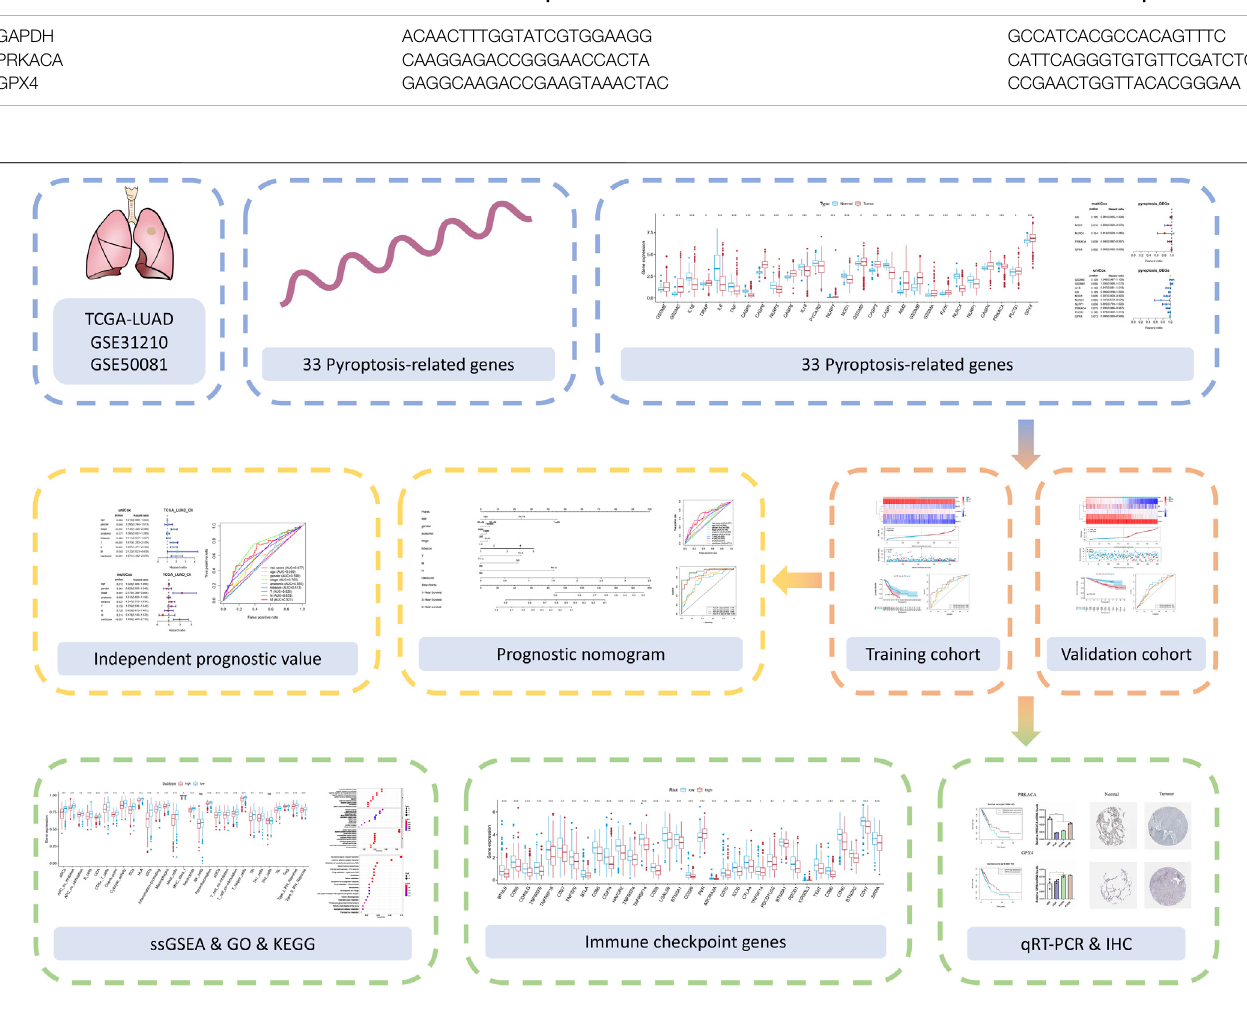
FIGURE 1 | The fl owchart of the